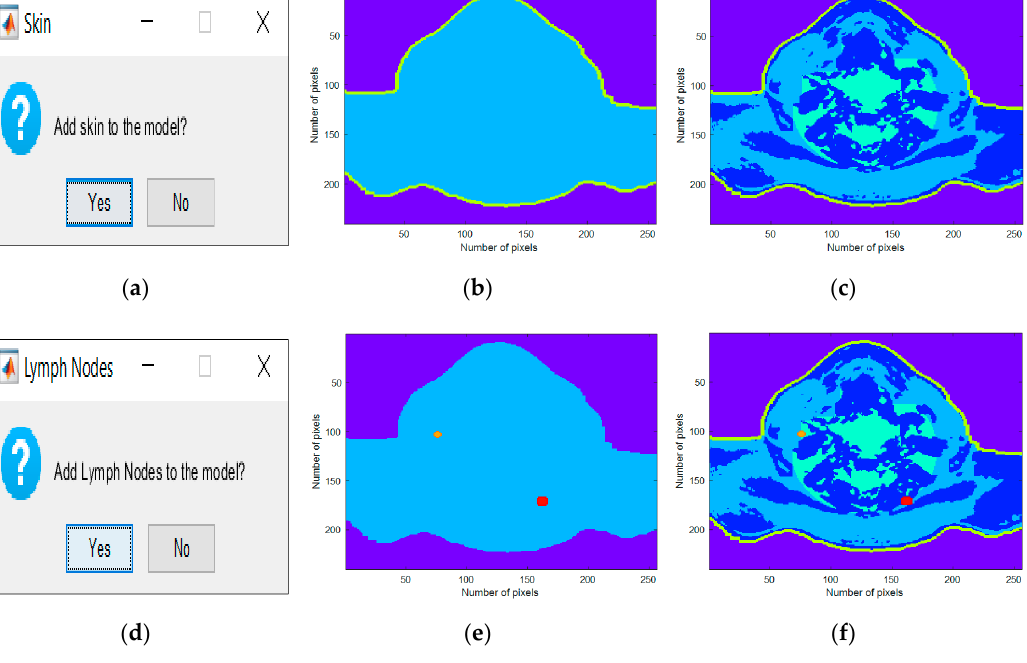
Figure 6. Interfaces created for the inclusion of the synthetic tissues. ( a ) Interface which allows the user to insert synthetic skin tissue in the phantom. ( b ) Axial slice of a 3D anthropomorphic head and neck phantom with skin tissue. ( c ) Axial slice of a 3D anthropomorphic head and neck phantom which combines fat, mixed, muscle and skin tissue. ( d ) Interface which allows the user to insert CLNs in the phantom. ( e ) Axial slice of a 3D anthropomorphic head and neck phantom with two CLNs: orange—with 1.5 mm major axis, healthy, and located on level II, and red—with 2.0 mm major axis, metastasized, and located on levels V. ( f ) Axial slice of a 3D anthropomorphic head and neck phantom which combines fat, mixed, muscle and skin tissues, and two CLNs.